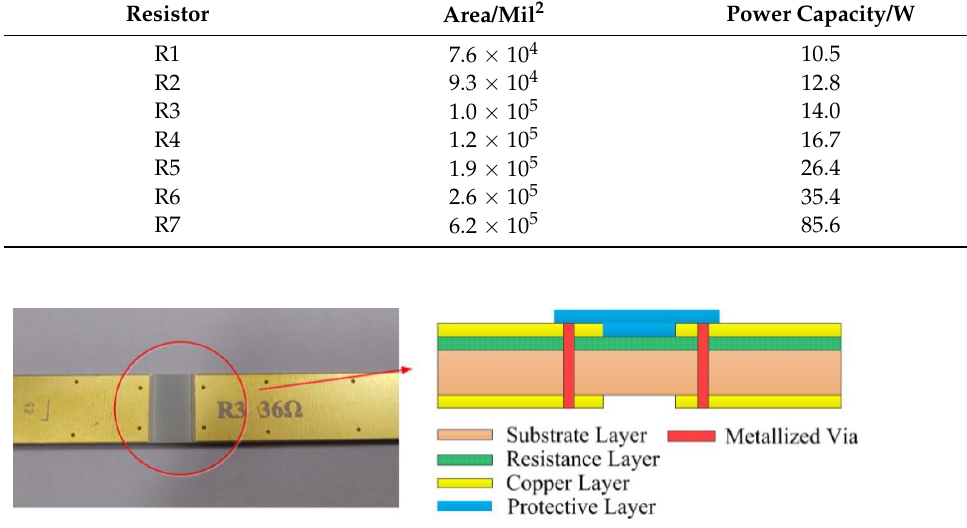
Figure 3. Structure of embedded resistance.